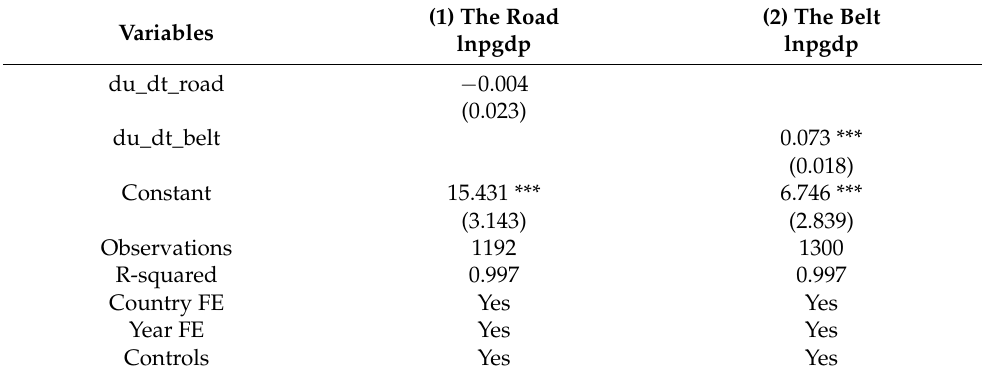
Table 5. The distinction of the Belt and the